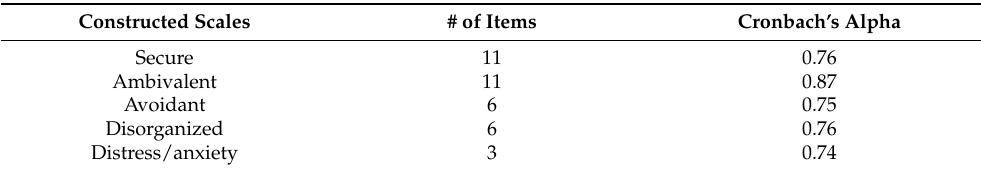
Table 3. Internal Consistency and Number of items of the Constructed Scales for the ASCT-LPN- coding system.